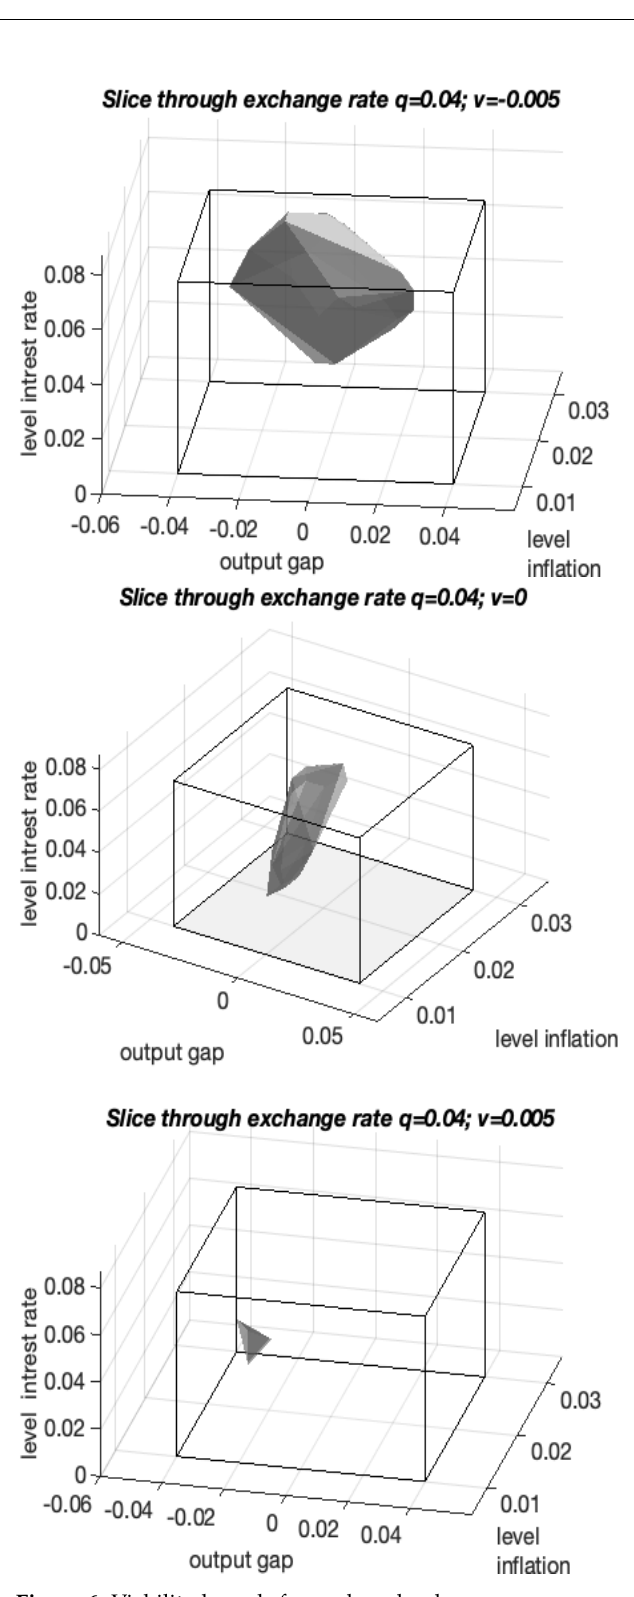
Figure 6. Viability kernels for undervalued